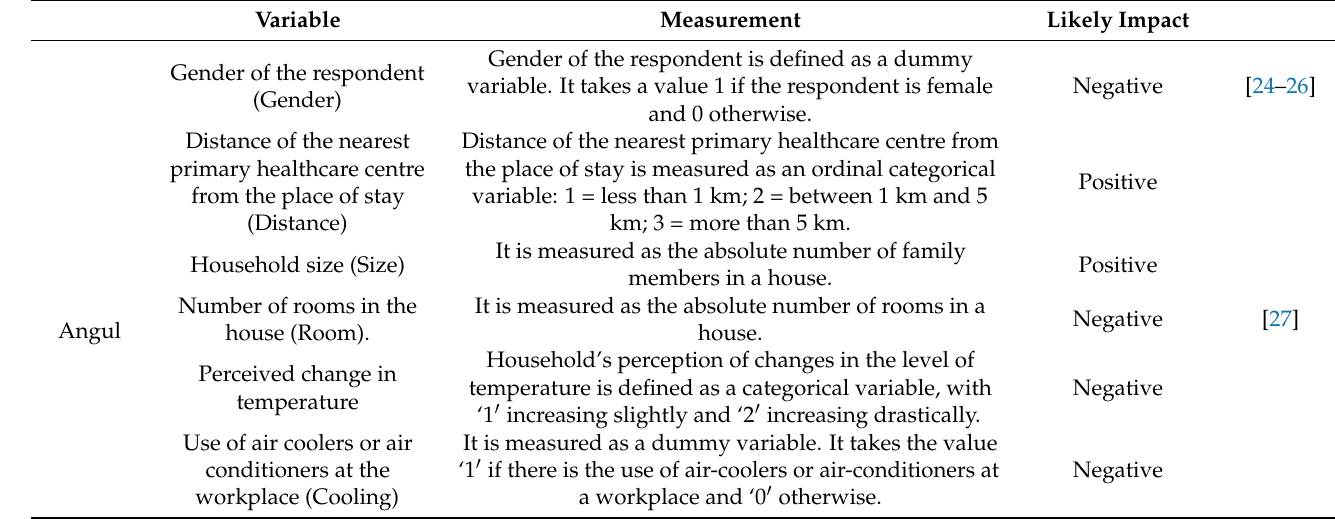
Table 1. Description of independent variables for Angul and